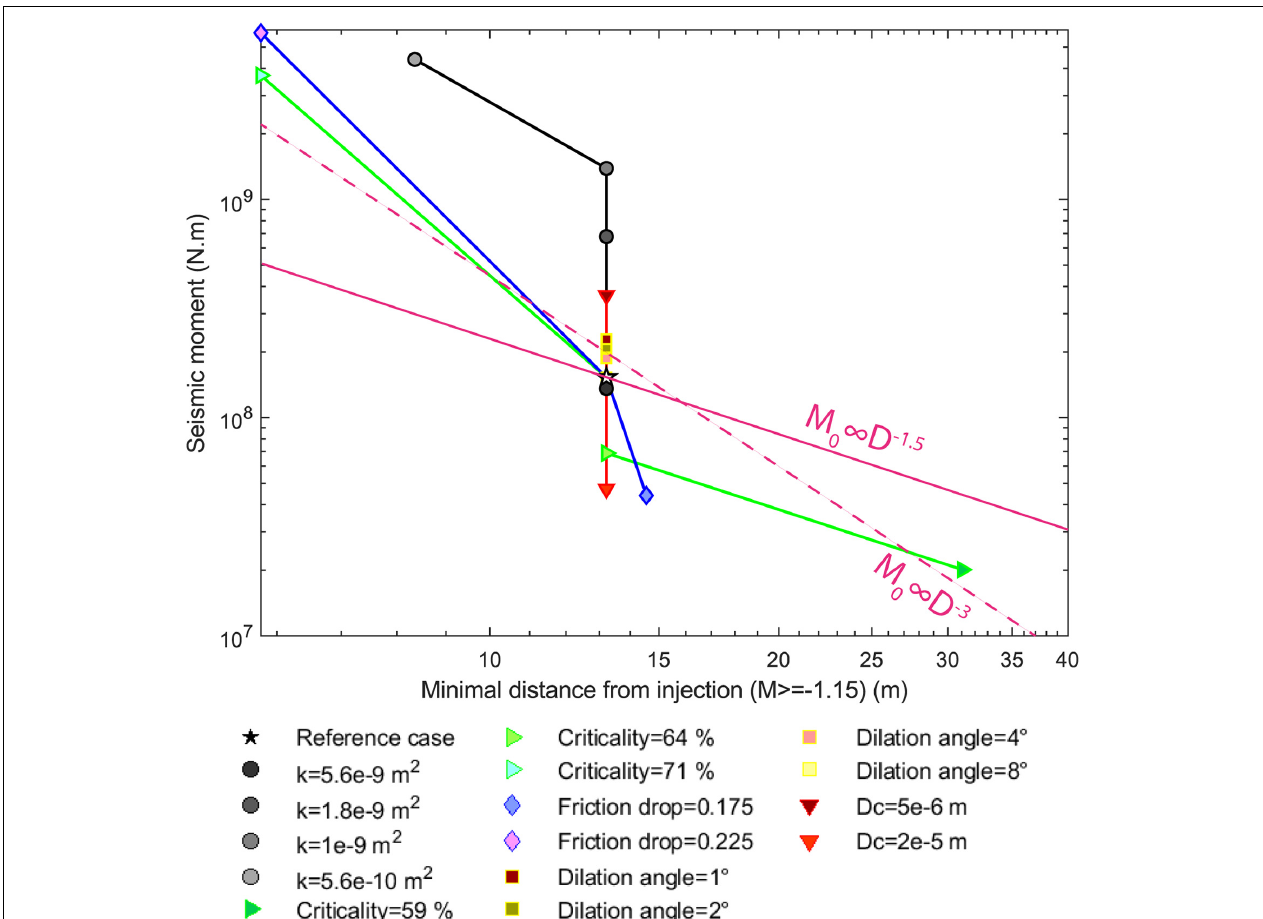
FIGURE 9 | Seismic moment as a function of the minimal distance from injection to seismic events whose magnitude exceeds –1.15 for the 16 simulations having at least one event with a moment magnitude above this threshold. Injection tests with a same varying parameter are linked by a single-colored line. Each test is defined by a color and a symbol. The reference case is represented by a star. The pink diagonal line represents the relation between seismic moment and distance from injection of the first detectable seismic event found by De Barros et al. (2019).